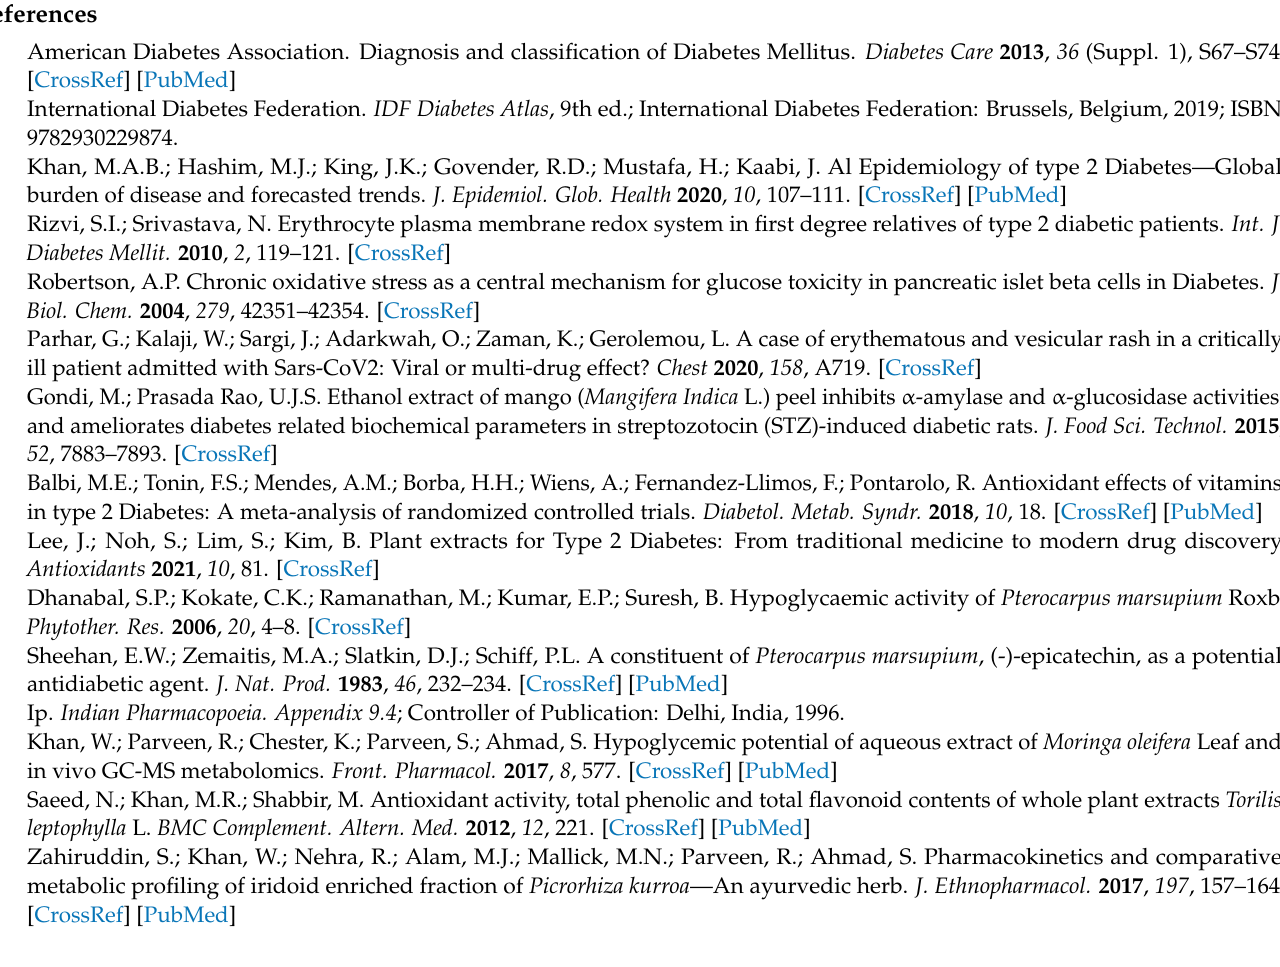
Figure S2: UPLC-MS chromatogram of MPME. Table S1: Physiochemical parameters of MPME. Table S2: HPTLC fingerprint of MPME at 254 nm and 366 nm. Table S3: Linear regression data for calibration plots of the analyzed marker using the proposed HPTLC